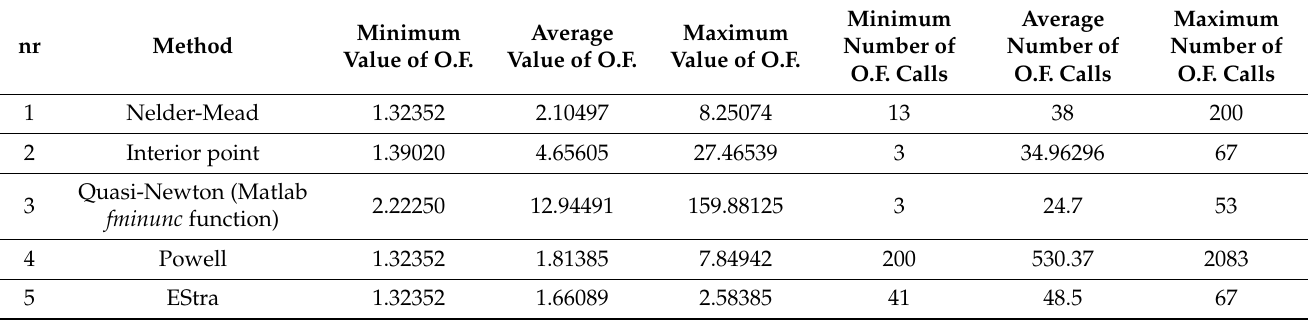
Figure 5. Set of 108 starting points regularly located in the parameter space ( L.r ) that are marked with “*” and objective function component— VSWR presented with contour lines for dipole benchmark. Table 1. Performance of the optimization in the case of VSWR minimization for 108 starting points (O.F.—Objective Function).